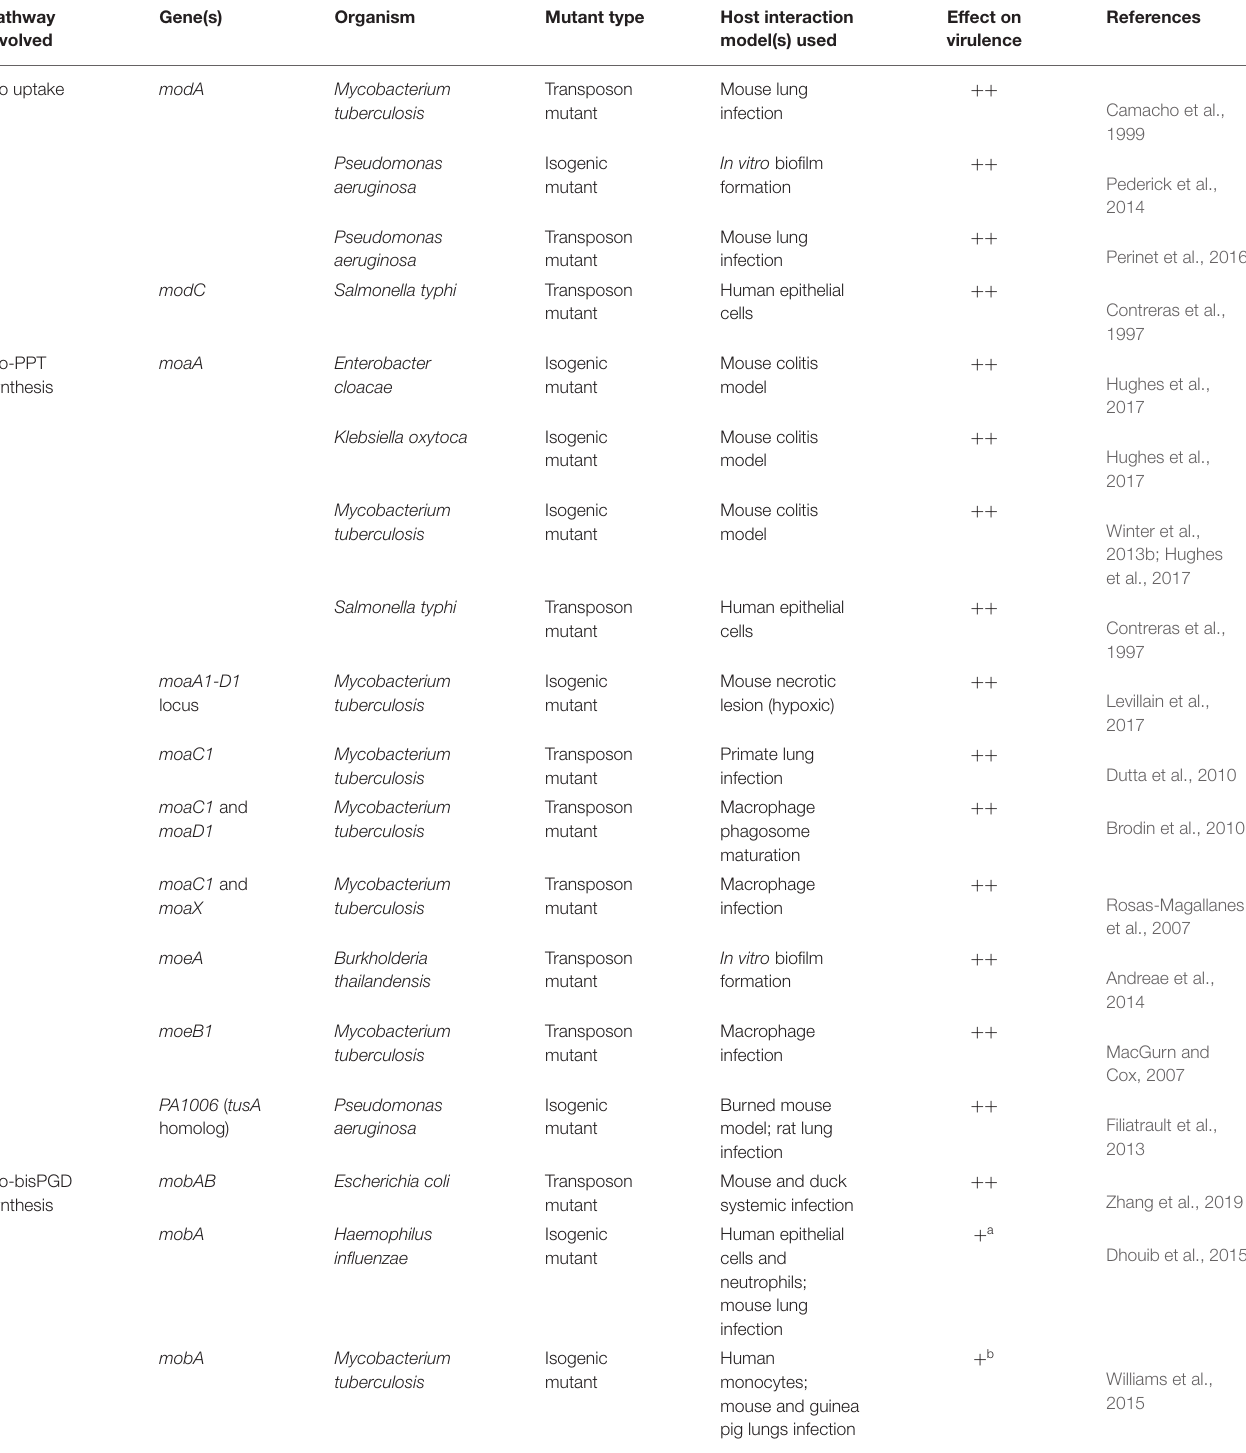
TABLE 1 | Defects in molybdate uptake or Mo-PPT biosynthesis genes and their effects on bacterial virulence. Pathway